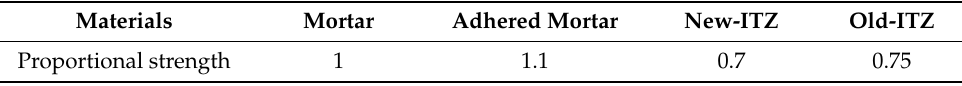
Table 3. The strength proportional relationship between components of